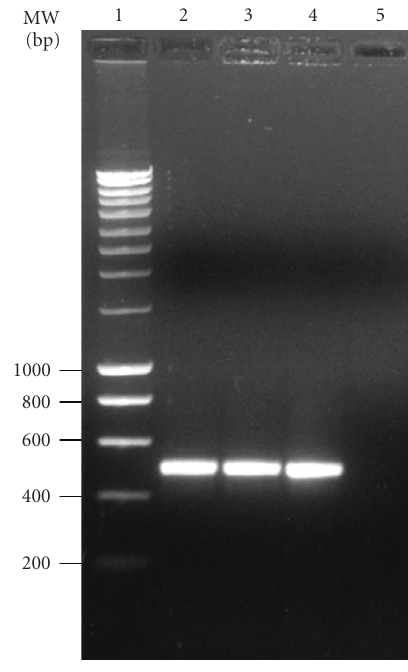
Figure 2: RT-PCR analysis of the A-domain expression in S. livi- dans 1326/pMS115. Lane 1: smart ladder molecular weight (MW) marker (Eurogentec). Lanes 2, 3, and 4: RT-PCR performed with cDNA synthesised from 2 μ g of RNA treated with DNase and pre- pared from the S. lividans 1326/pMS115 strain grown on TSB medium for 36 h, 50 h, and 60h, respectively. Lane 5: PCR per- formed directly with 2 μ g of RNA treated with DNase (control).